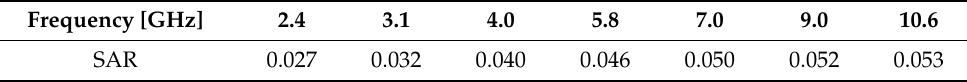
Table 4. Simulated SAR-values at different frequencies as the input power is 5